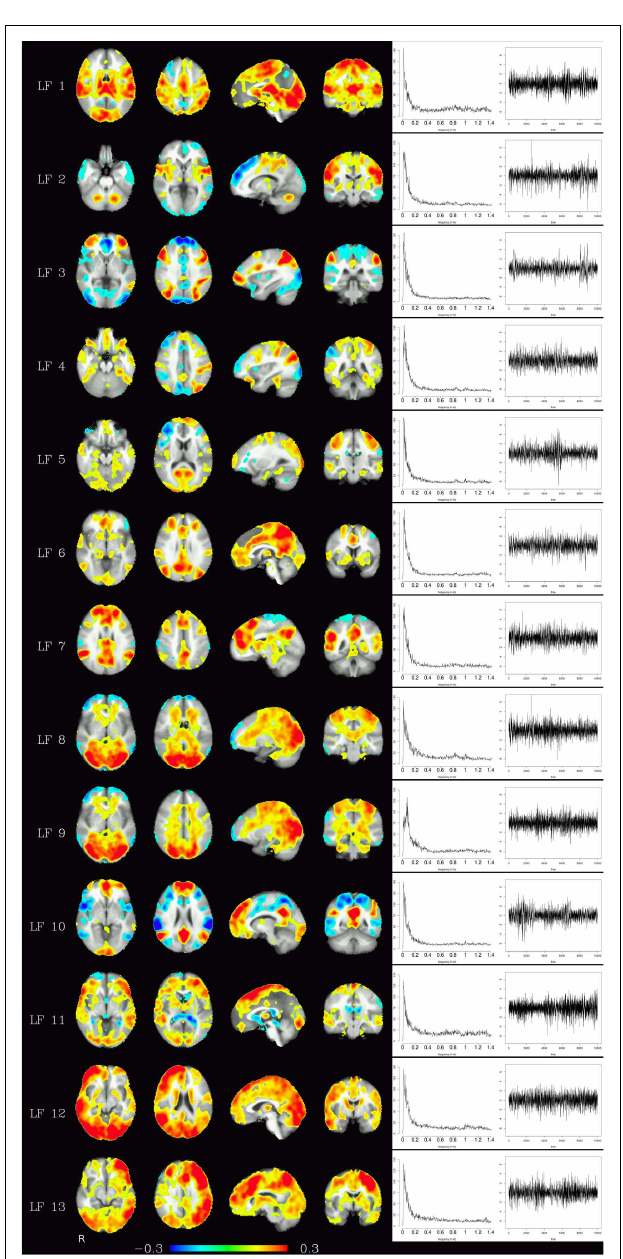
FIGURE 4 | Depending on the number of components chosen, various temporally independent low-frequency components ( ≤ 0.25Hz) are separated by the algorithm (LF 1–LF 13, left row) . Note that time courses and corresponding frequency spectra (right side) are not contaminated by any high-frequency components (e.g., respiration, heart-beat, etc.), increasing functional contrast-to-noise ratio.The interpretation whether a component is (predominantly) of vascular or brain tissue origin, however, is not obvious from the spectra